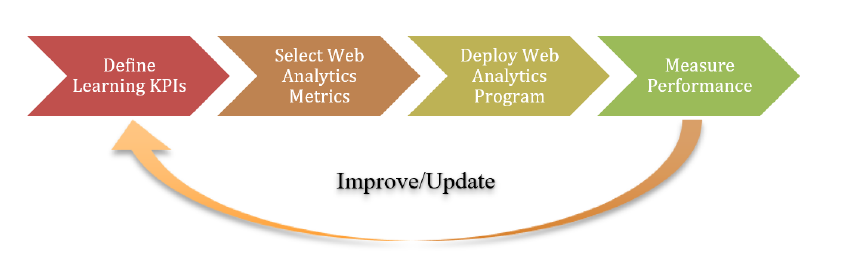
Fig. 5. Web analytics-based evaluation